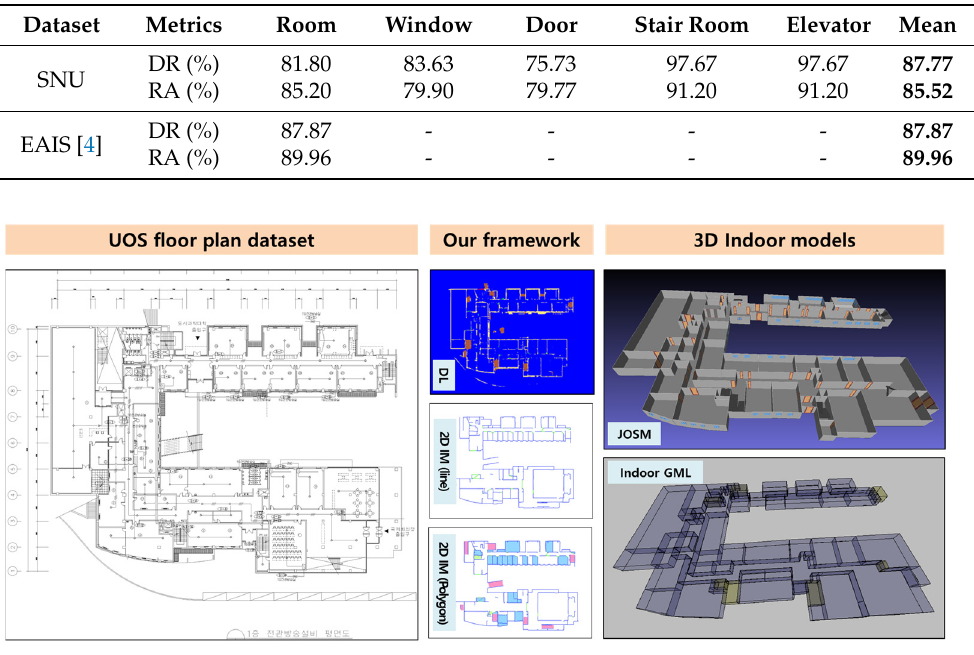
Figure 6. Application of our framework to the UOS dataset.